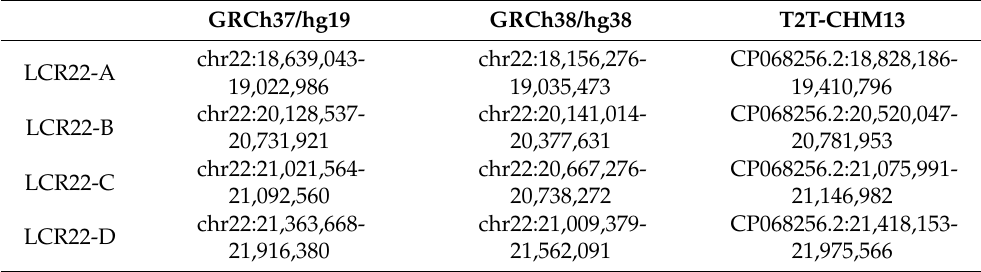
Table 1. Exact chromosomal locations of the different LCR22s in hg19, hg38, and telomere-to-telomere reference